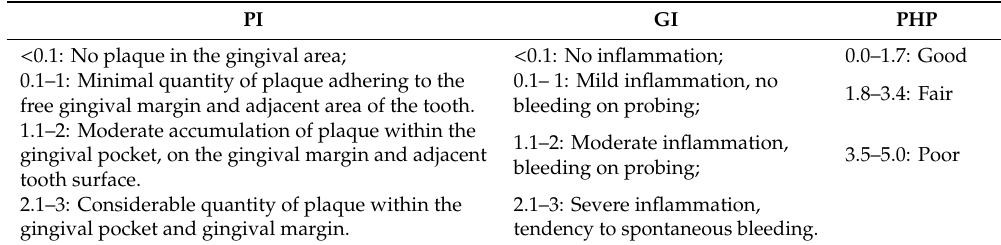
Table 1. Oral hygiene parameters. (patient hygiene performance index (PHP), gingival index (GI), plaque index (PI), and frequency of tooth brushing